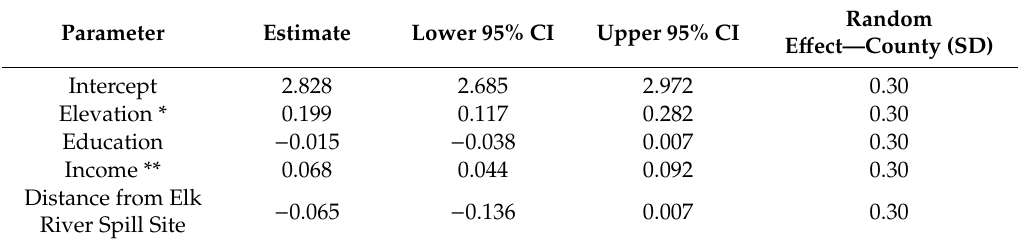
Table 2. Linear mixed model results for overall water quality perception score as the dependent variable of interest. Note: * p < 0.05; ** p <